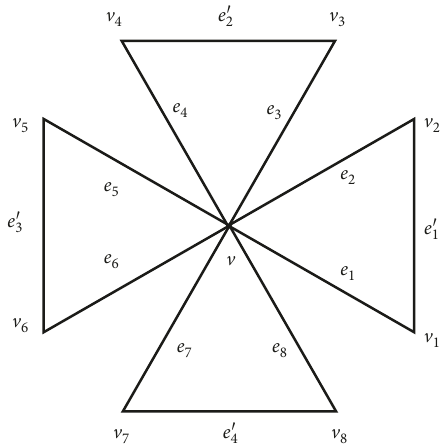
Figure 4: Friendship graph ( F